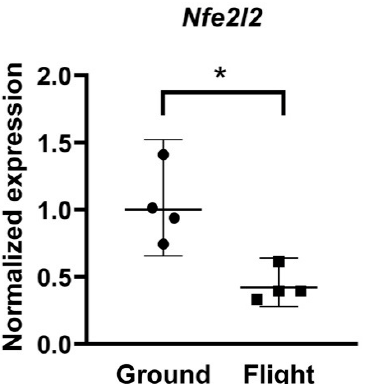
Figure 2. Normalized expression levels of Nfe2l2 as measured by a separate RT-PCR assay. Each data point is shown. The middle lines indicate the geometric mean (normalized expression of 1 for Ground Control and 0.42 for Spaceflight group). Outer lines show the 95% confidence intervals. * Statistically significant by Mann–Whitney U test at p < 0.05, n = 4. The log2 (linear) normalized expression from the Ground Control and Flight groups were used in the Mann–Whitney U test.